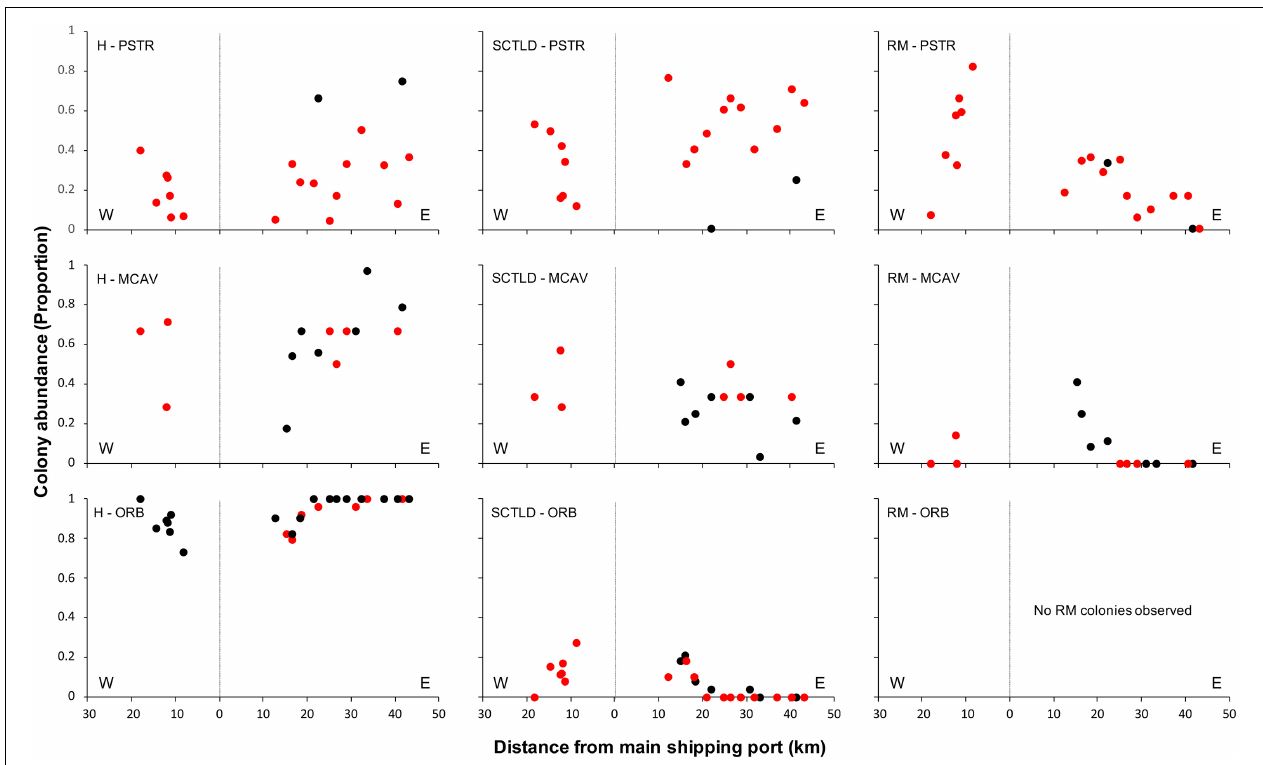
FIGURE 3 | Proportion of colonies from Grand Bahama that were healthy (H, left), infected with SCTLD (middle), or experienced recent mortality (RM, right) for Pseudodiploria strigosa (PSTR), Montastraea cavernosa (MCAV), and Orbicella spp. (ORB), plotted against distance east and west of the port facility (distance = 0). Deep reefs ( > 10 m) are shown in black and shallow reefs ( ≤ 10 m) in